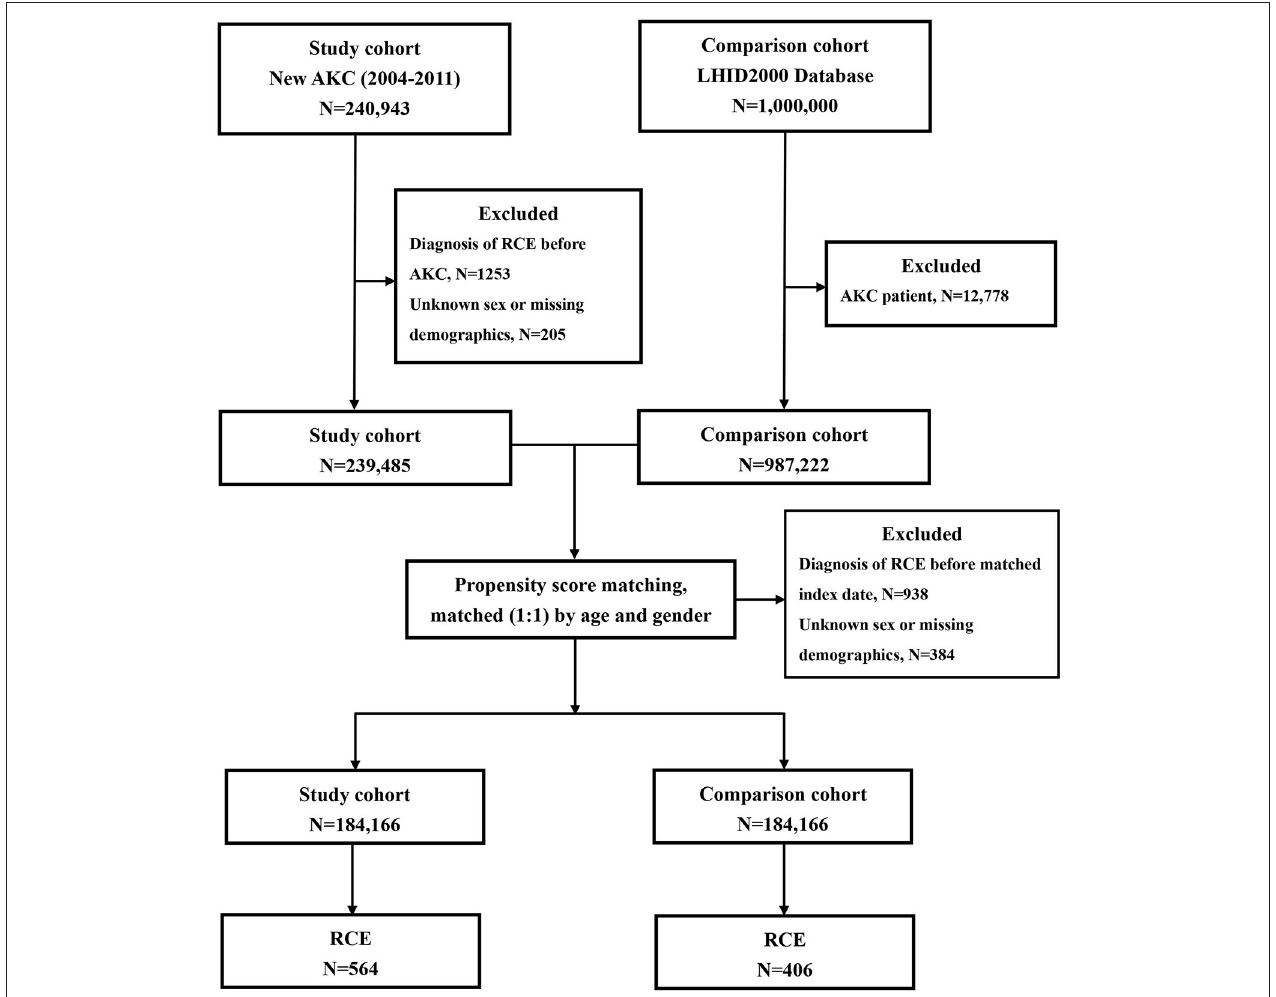
FIGURE 1 | The flowchart for patients with atopic keratoconjunctivitis (AKC) and controls